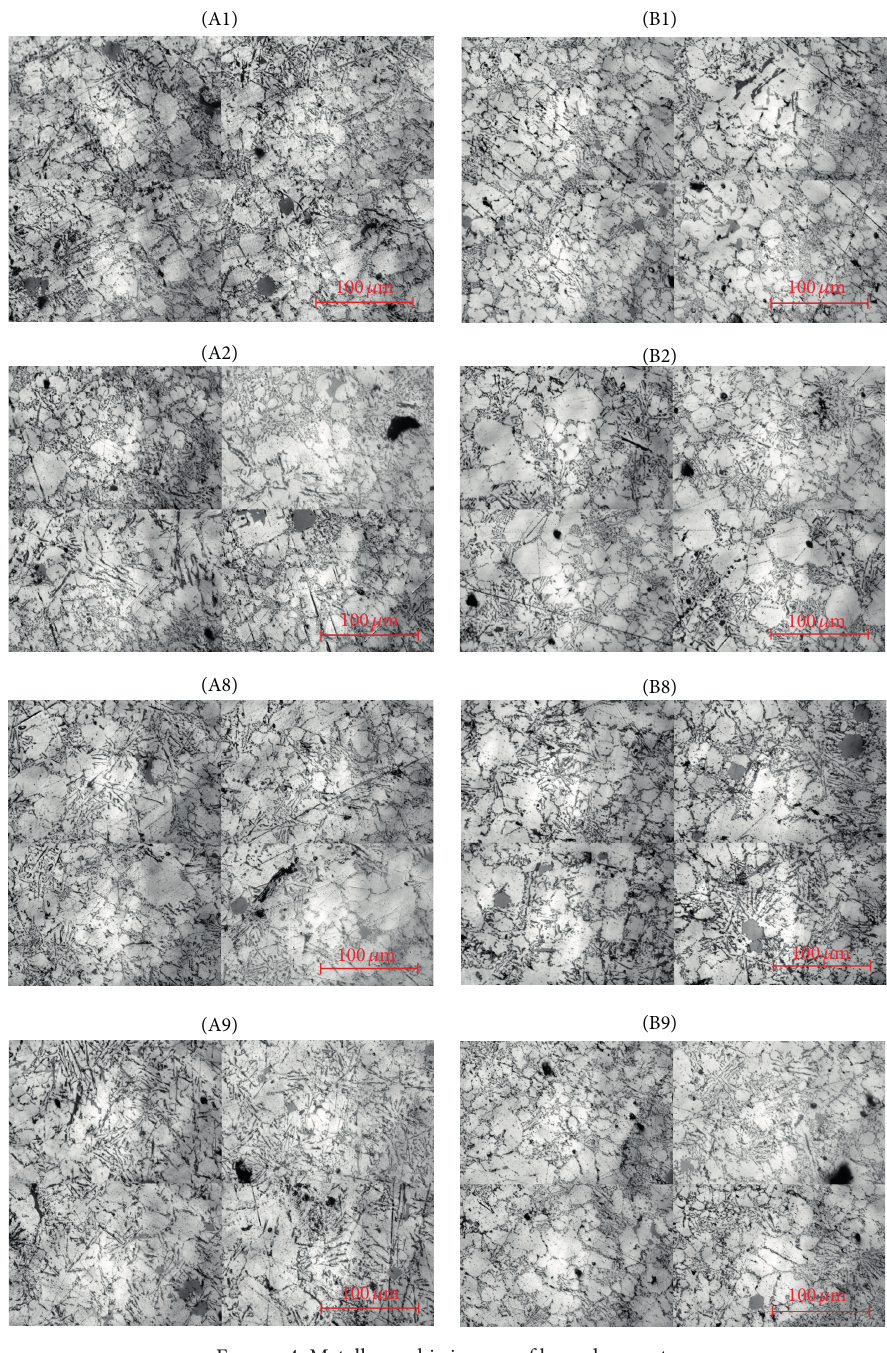
Figure 4: Metallographic images of boundary